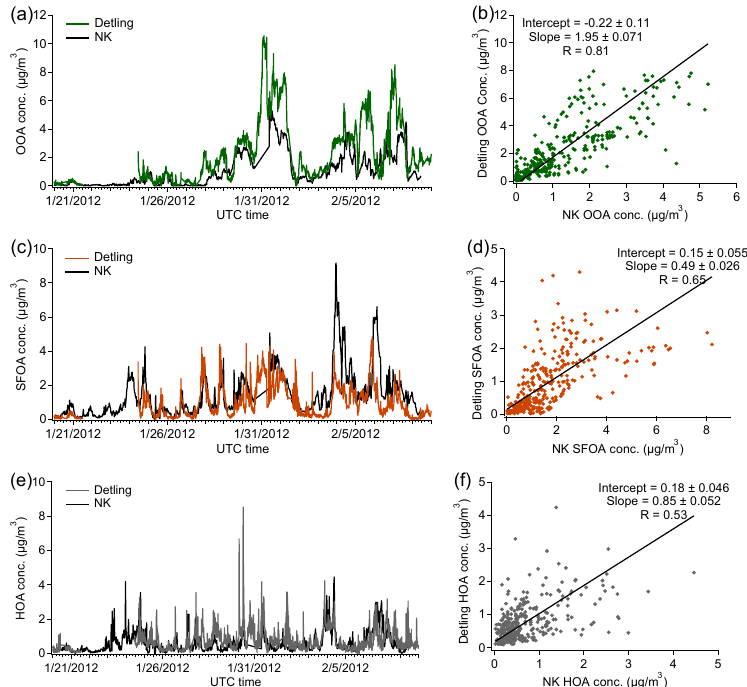
Figure 8. Comparison of OA factors time series between NK and Detling sites. The intercept and slope are obtained by orthogonal distance regression. The Pearson’s R is obtained by linear least-squares